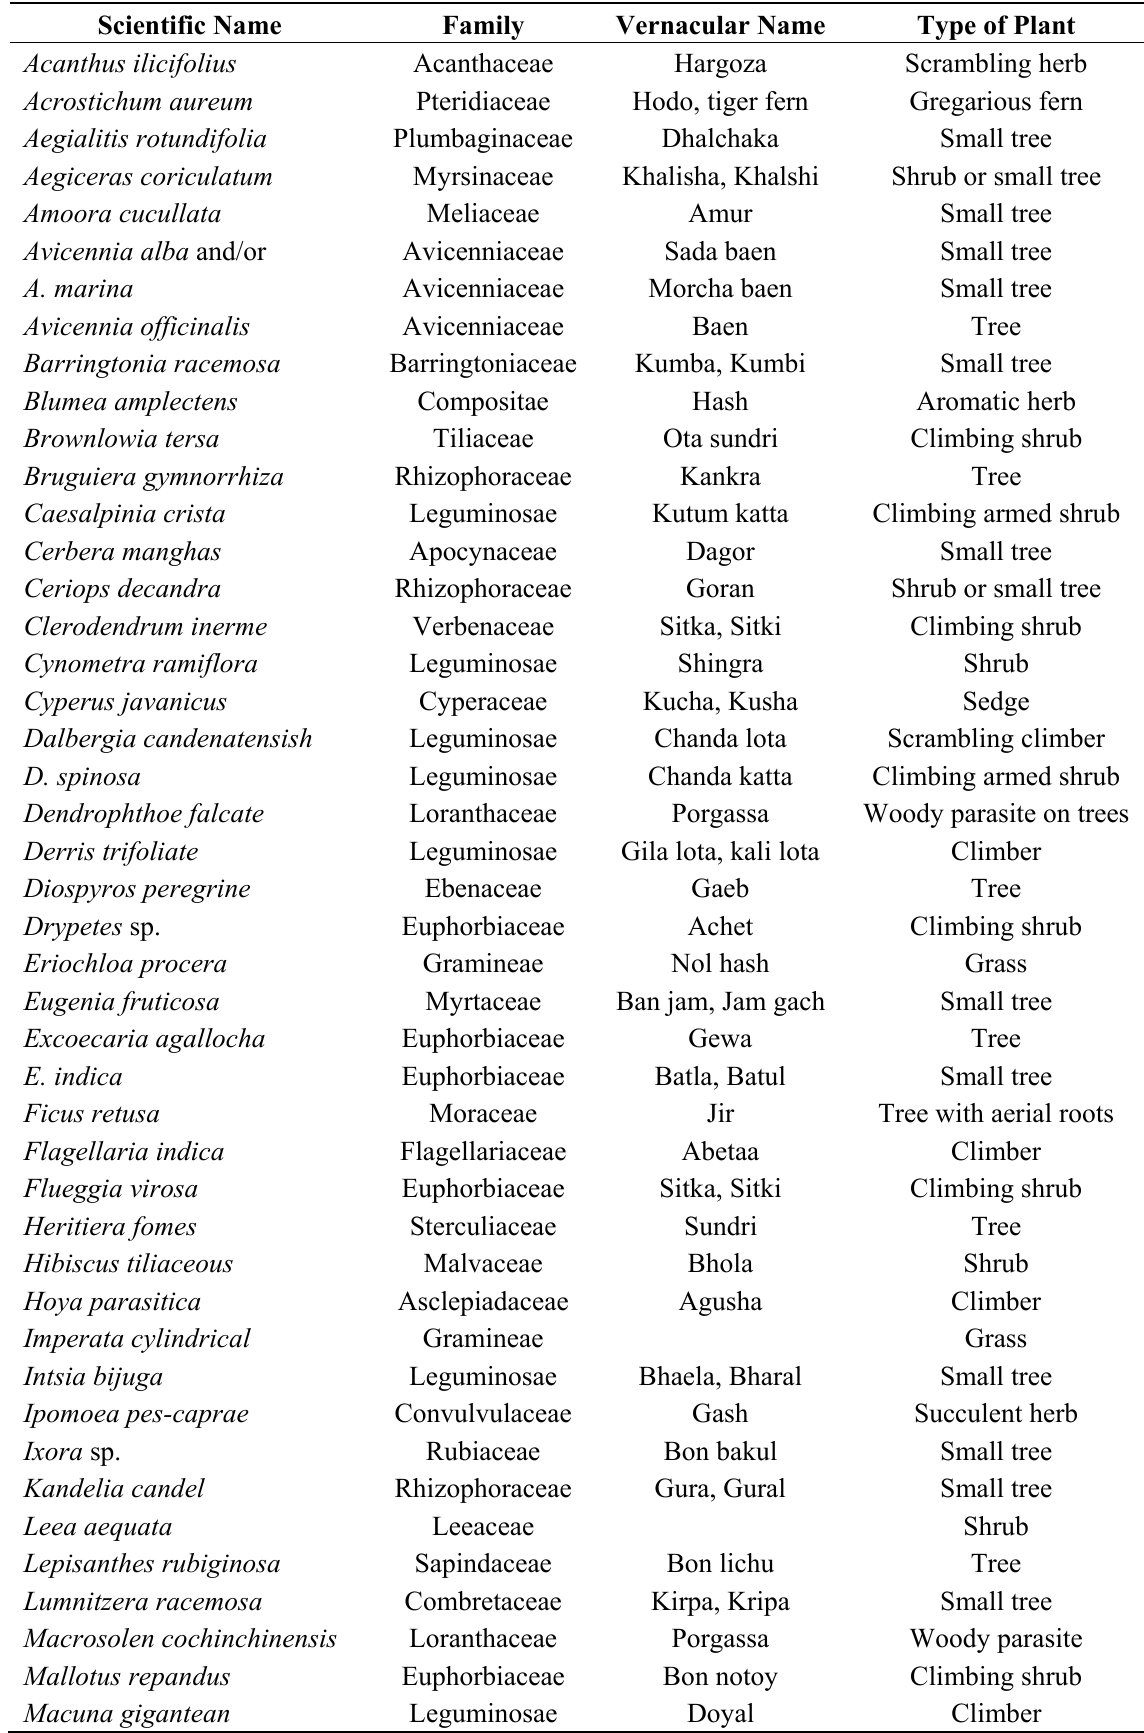
Table 2. Flora of the Bangladesh Sundarbans